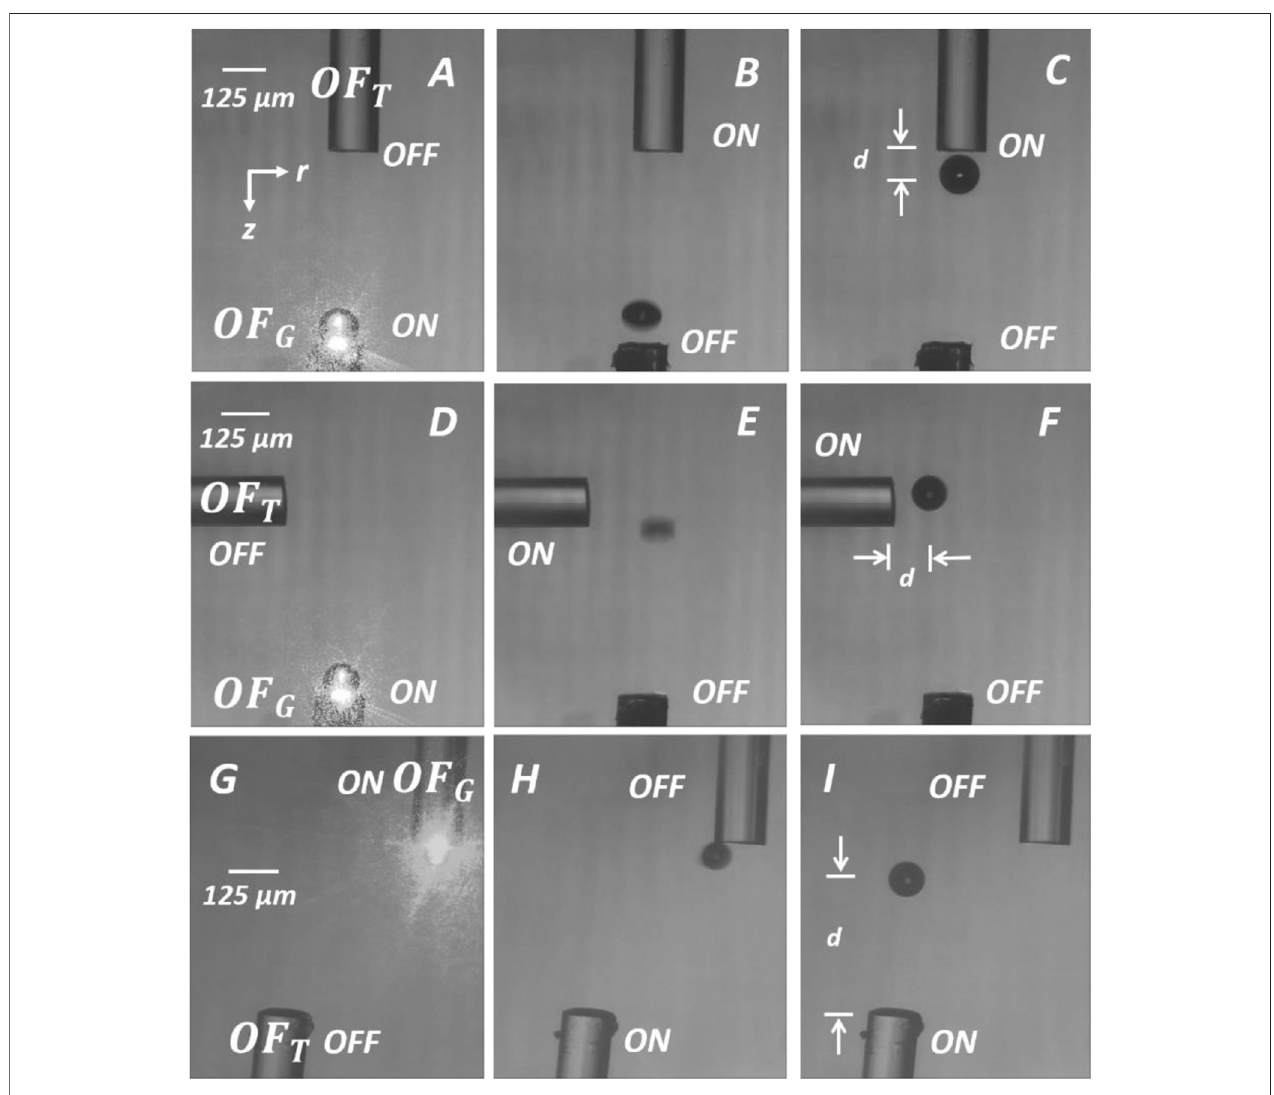
FIGURE2| Generationand3Dtrappingofamicrobubble fordifferent fi ber OF T positions:facingdownwards2A,horizontally2D,and upwards2G.Bubble release from the fi ber OF G : 2B, 2E, and 2H. Bubble trapping 2C, 2F, and 2I. See visualizations 1, 2, and 3 for more details.